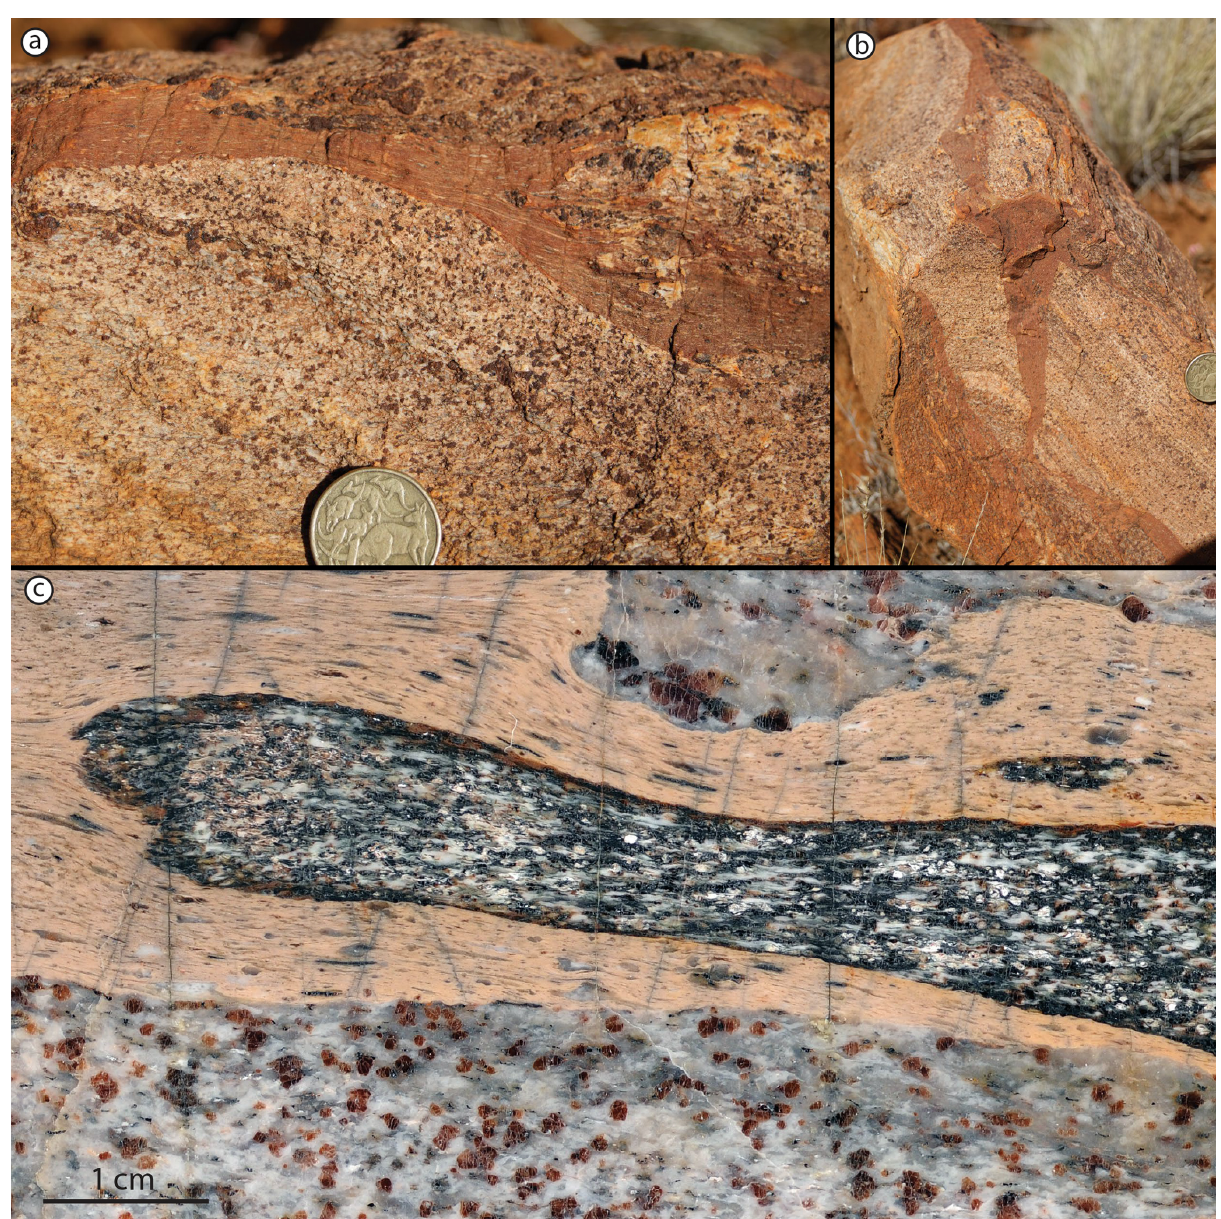
Figure 2. Sheared pseudotachylyte in a view orthogonal to the foliation of host felsic mylonite and looking (a) perpendicular and (b) parallel to the stretching lineation. (c) Polished hand specimen of a sheared pseudotachylyte breccia with the caramel-coloured foliated pseudotachylyte matrix including elongated clasts and an elongated fragment of mafic granulite. The host rock shows millimetre-sized garnets with fractures. The plane of the polished surface is perpendicular to the foliation and parallel to the stretching